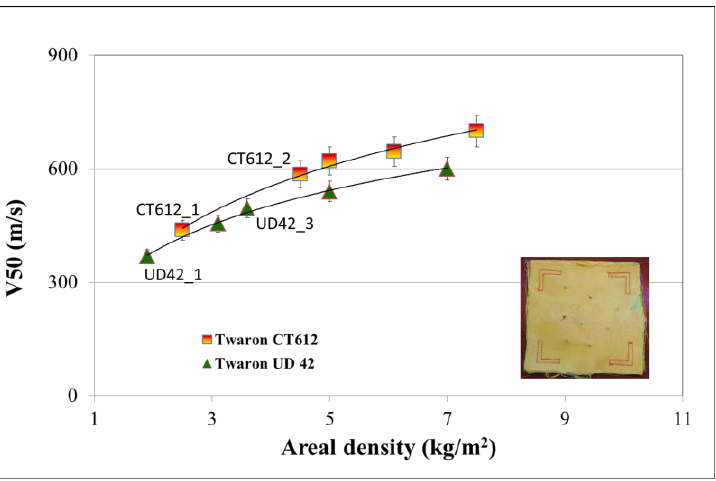
Figure 1. Soft ballistic inserts made from Twaron ® CT612 and Twaron ® UD42 after FSP.22 fragment resistance tests.